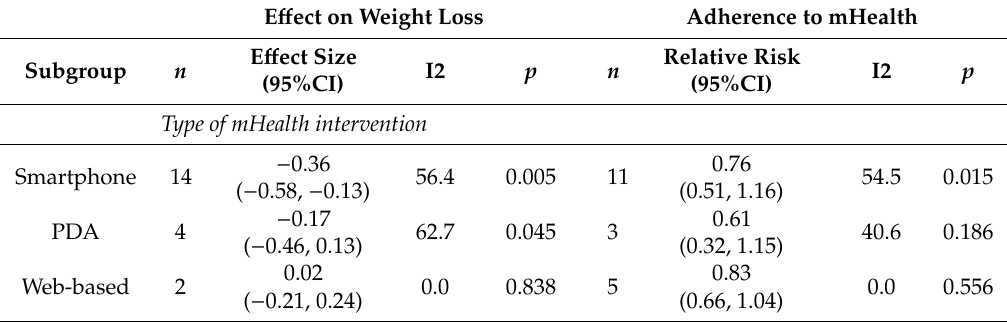
Table 3. Subgroup analyses for pooled effect on weight loss and adherence to mHealth group according to type of mHealth intervention, type of comparison and length of intervention.